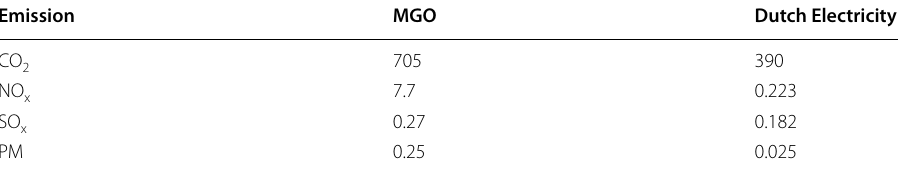
Table 5 Overview of emissions per kWh for fuel and electricity. Source : (CEDelft 2020)